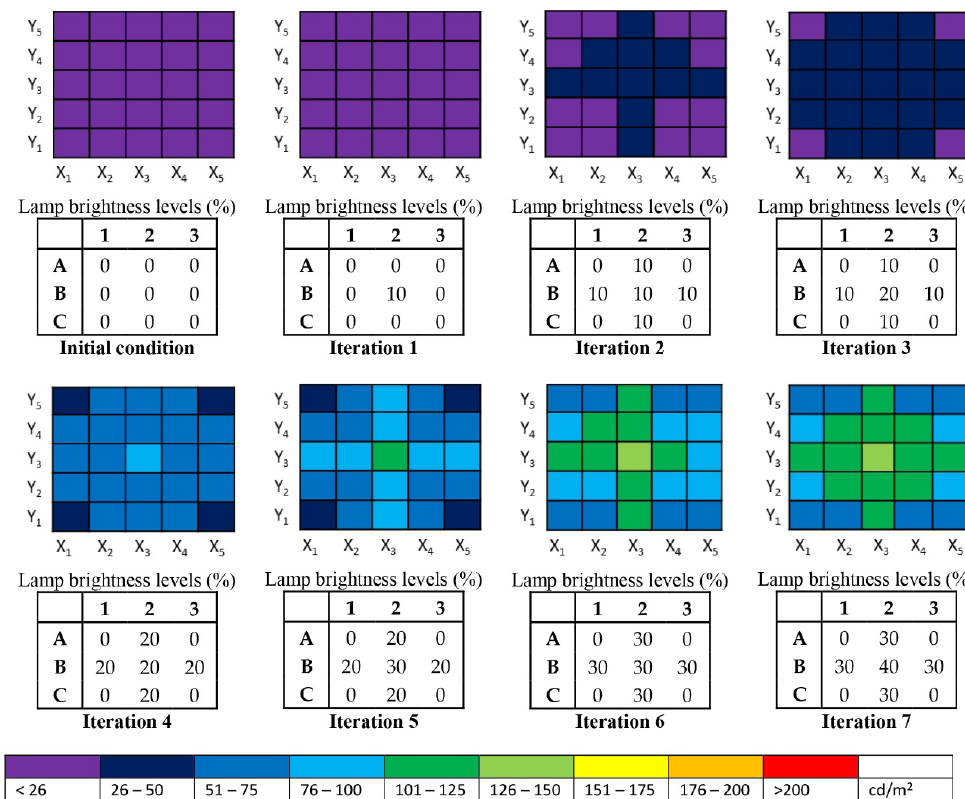
Figure 13. The luminance values and lamp brightness levels for Measurement Scheme 3A.